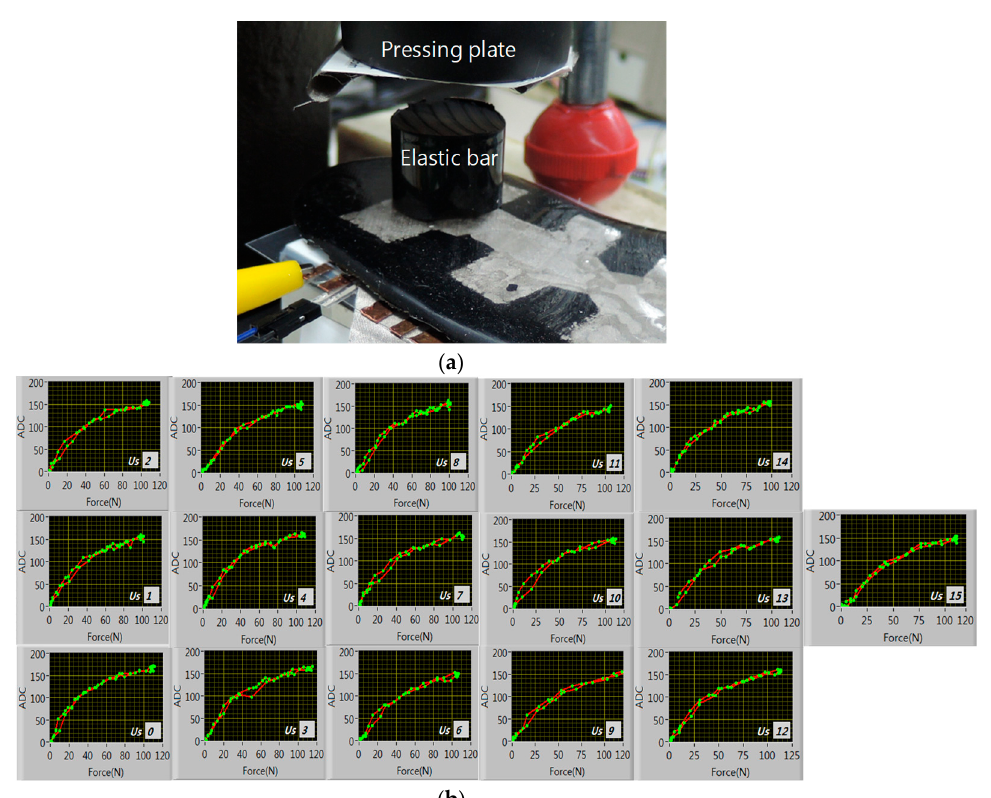
Figure 10. Insole cell calibration setup: ( a ) cell testing setup, ( b ) the ADC hysteresis curves of 16 insole cells.